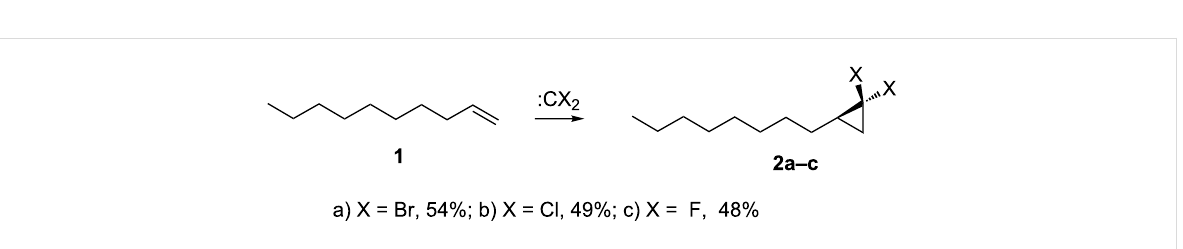
Scheme 1: Model reactions of dec-1-ene ( 1 ) with dihalocarbenes in the liquid phase. a) and b) NaOH, BTEAC, CHX 3 , DCM, 8 h, 25 °C; c) TMSCF 3 , THF, NaI, 3 h, 65